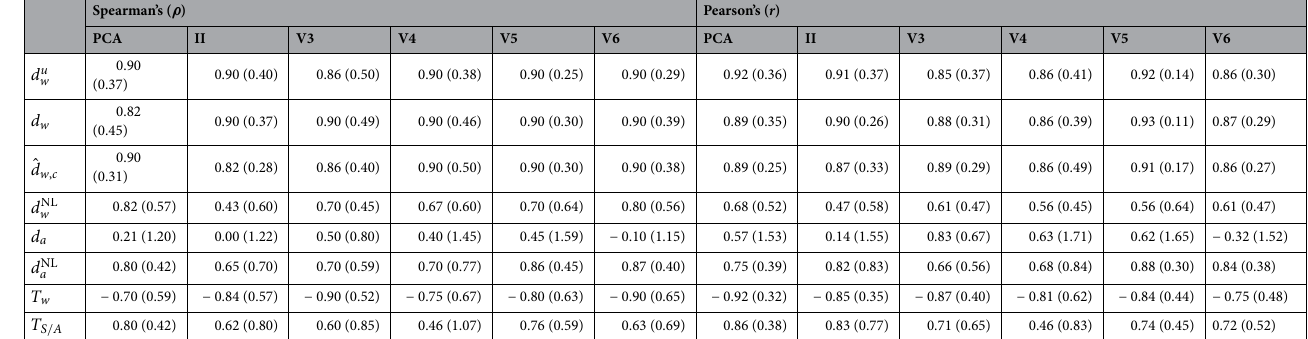
Table 4. Intra-patient Spearman’s ( ρ ) and Pearson’s ( r ) correlation coefficients between (cid:31) [ K + ] , and time- warping based markers, and T w and T S / A , in all cases evaluated from the first PCA transformed lead, and from standard single leads II, V3, V4, V5 and V6. Values are expressed as median